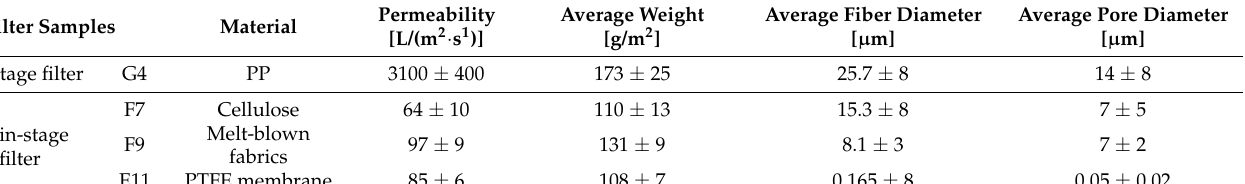
Table 1. The properties of pre-stage and main-stage filter samples.